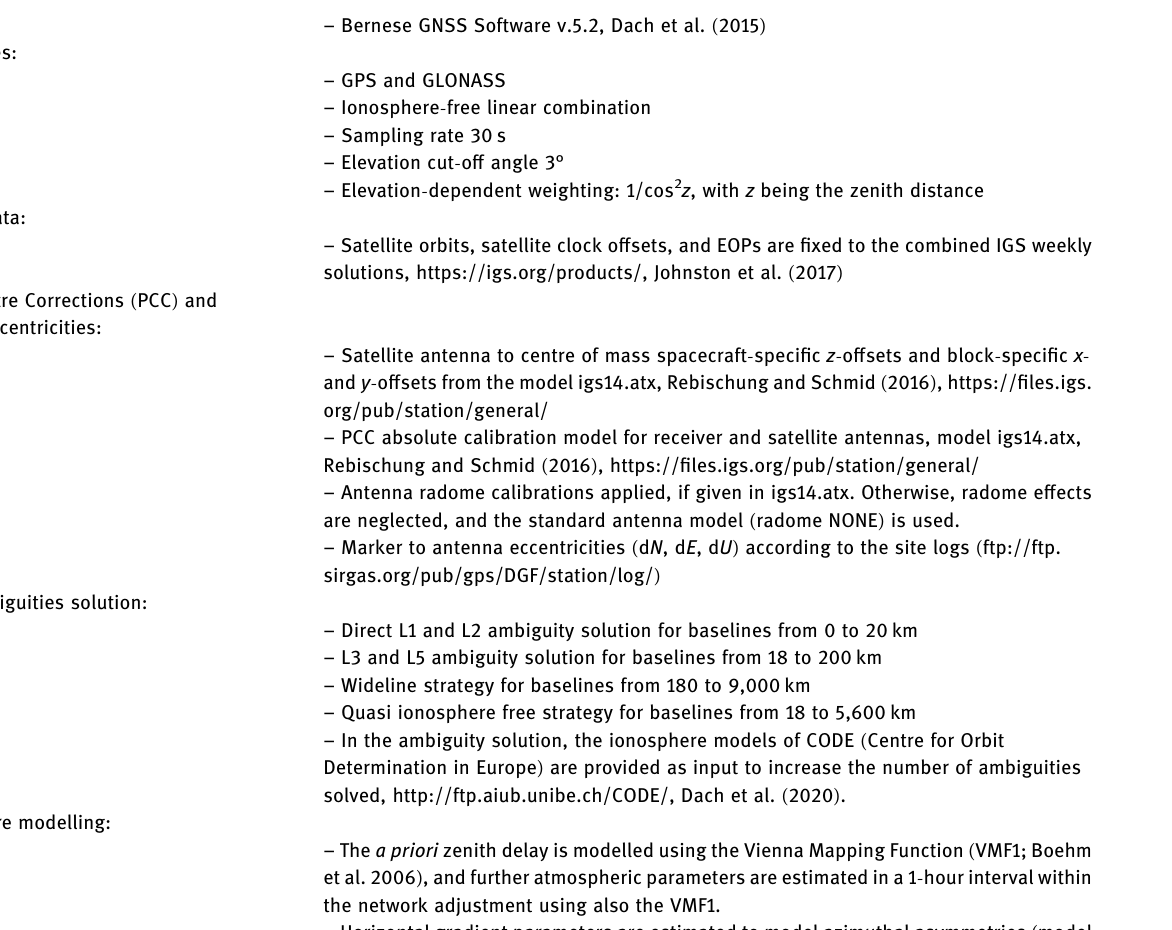
Table 2: GNSS data processing standards applied at DGFT - TUM for the analysis of the SIRGAS reference frame